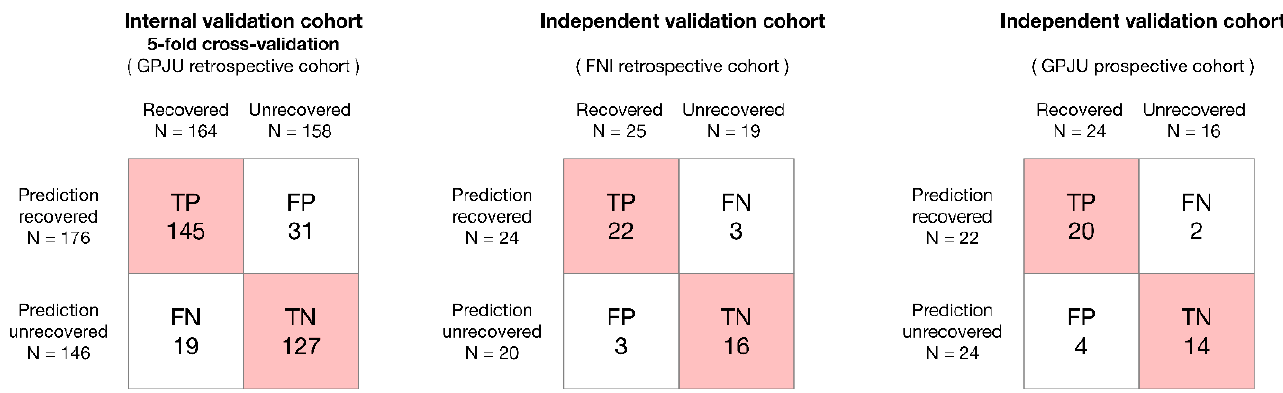
Figure 3. Confusion matrix in the training and validation cohorts. We investigated the utility of our model by plotting a decision support curve. The curve presented that the net benefit of our full model was higher than the non-model or model only using the visual field as the predictor (baseline model). PREVOST provided greater net benefit than the competing extremes of intervening in all patients or none (Figure 4A). At most risk thresholds greater than 0.1, the full model provided significant improvement in net benefit compared with the baseline model. Moreover, the model showed good calibration with low Brier scores (0.055; Figure 4B).